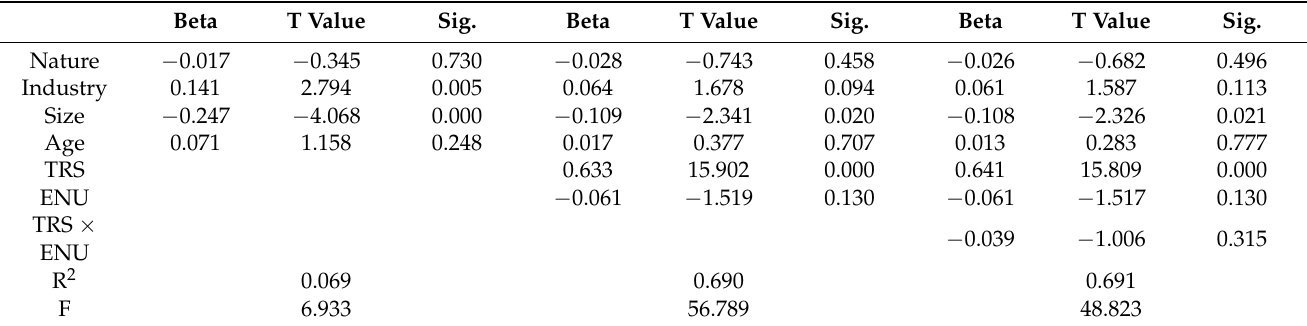
Table 9. Moderating effect